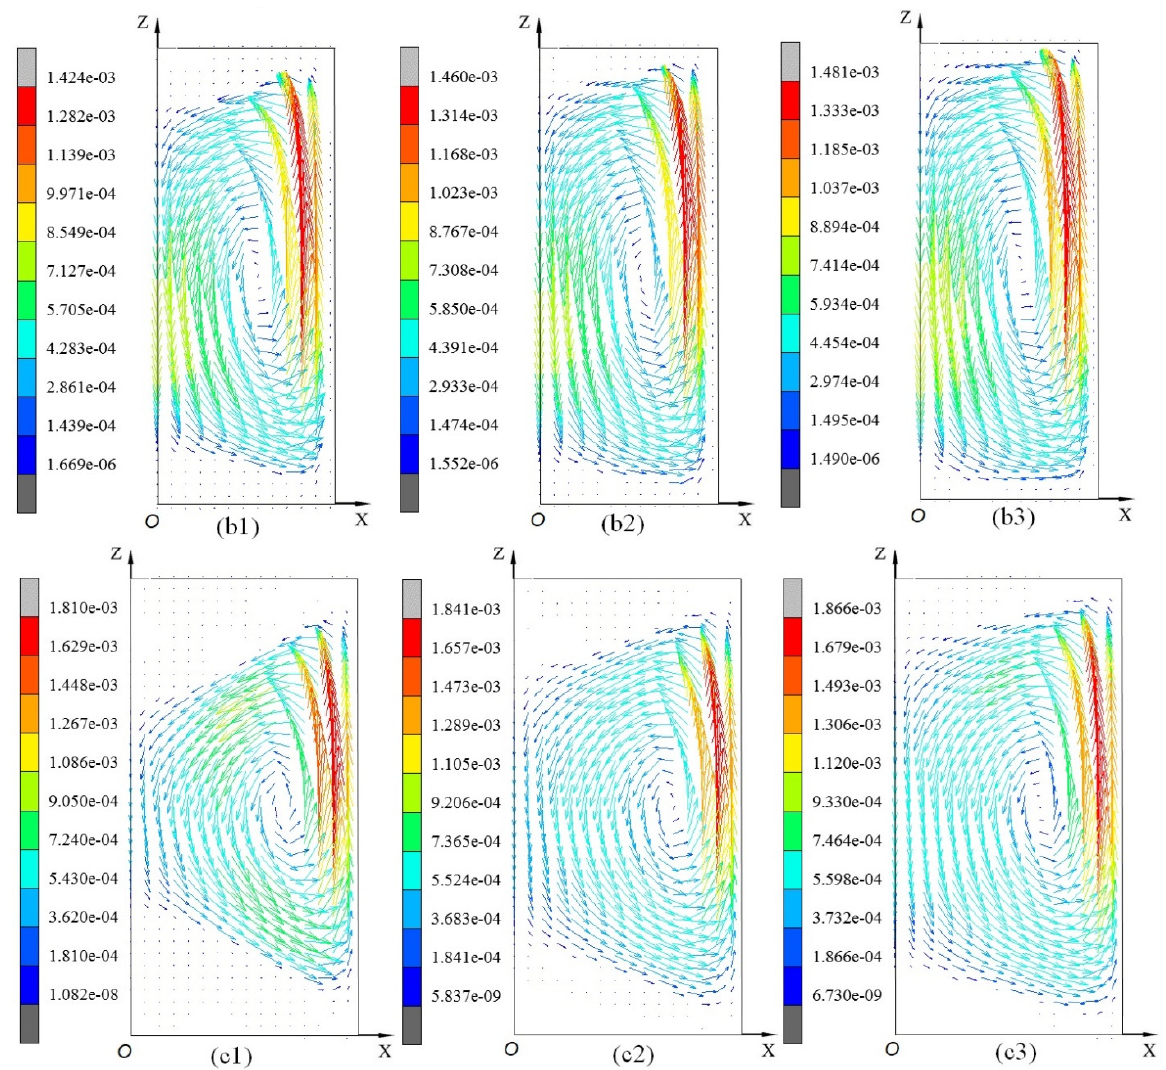
Figure 6. The vector graphs of fluid flow when the melting zone is 0.08–0.12 m from the bottom of the crucible. ( a1 ) crystal radius 0.01 m, the maximum furnace temperature 1030 K; ( a2 ) 0.01 m, 1040 K; ( a3 ) 0.01 m, 1050 K; ( b1 ) 0.015 m, 1030 K; ( b2 ) 0.015 m, 1040 K; ( b3 ) 0.015 m, 1050 K; ( c1 ) 0.02 m, 1030 K; ( c2 ) 0.02 m, 1040 K; ( c3 ) 0.02 m, 1050 K.